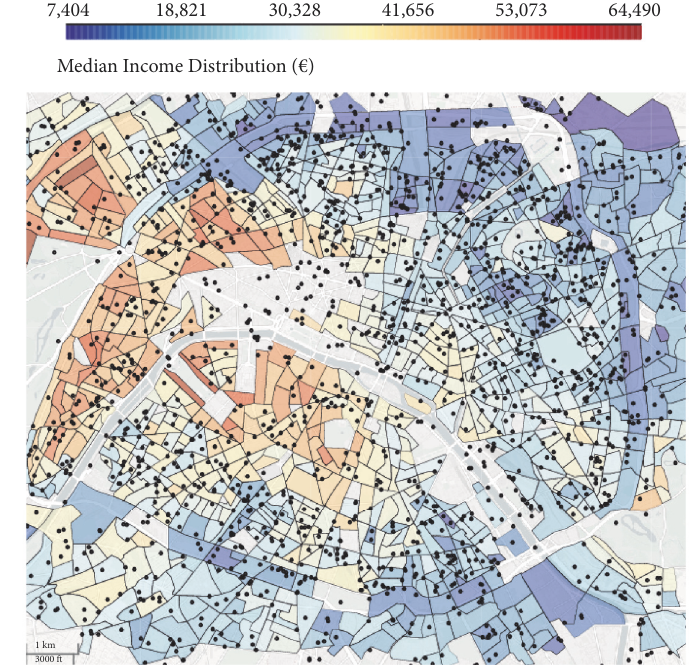
Figure 2: IRIS area cells in centralParis colored according to the median income of inhabitants, with inferred homelocations of 2,000Twitter